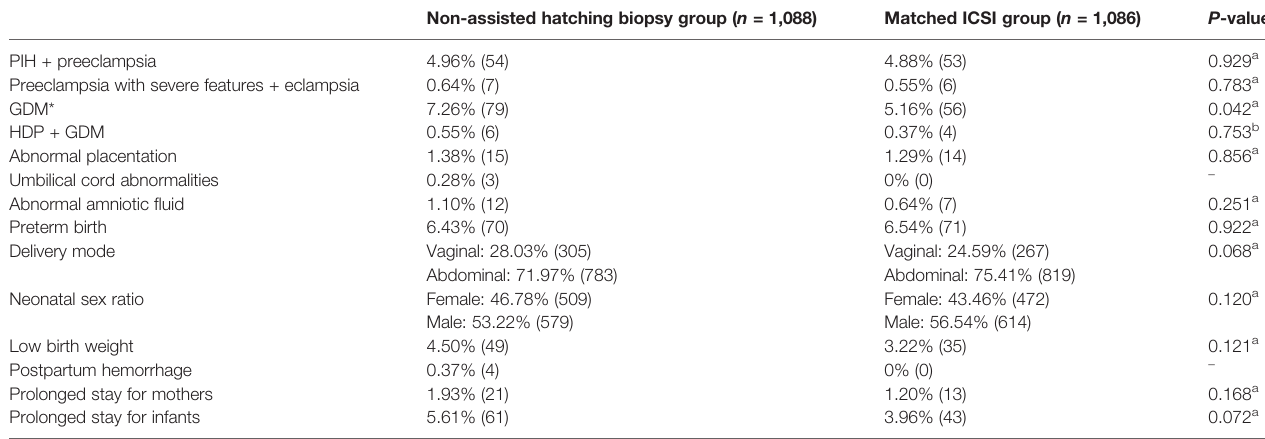
TABLE 3 | Comparisons of maternal and neonatal outcomes between the non-assisted hatching biopsy group and the matched ICSI group. Non-assisted hatching biopsy group ( n =